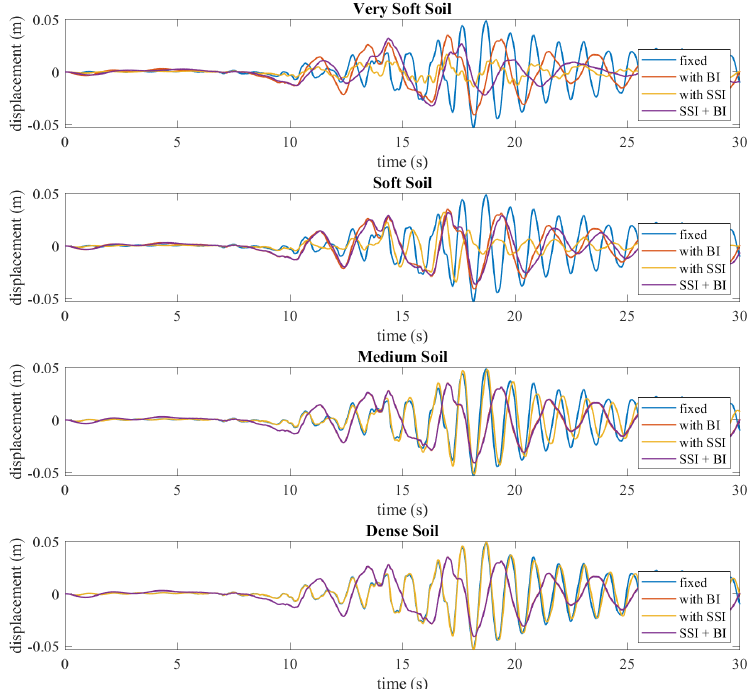
Figure 7. Top story displacement–time history of the ten ‐ story building (Kocaeli, 1999).